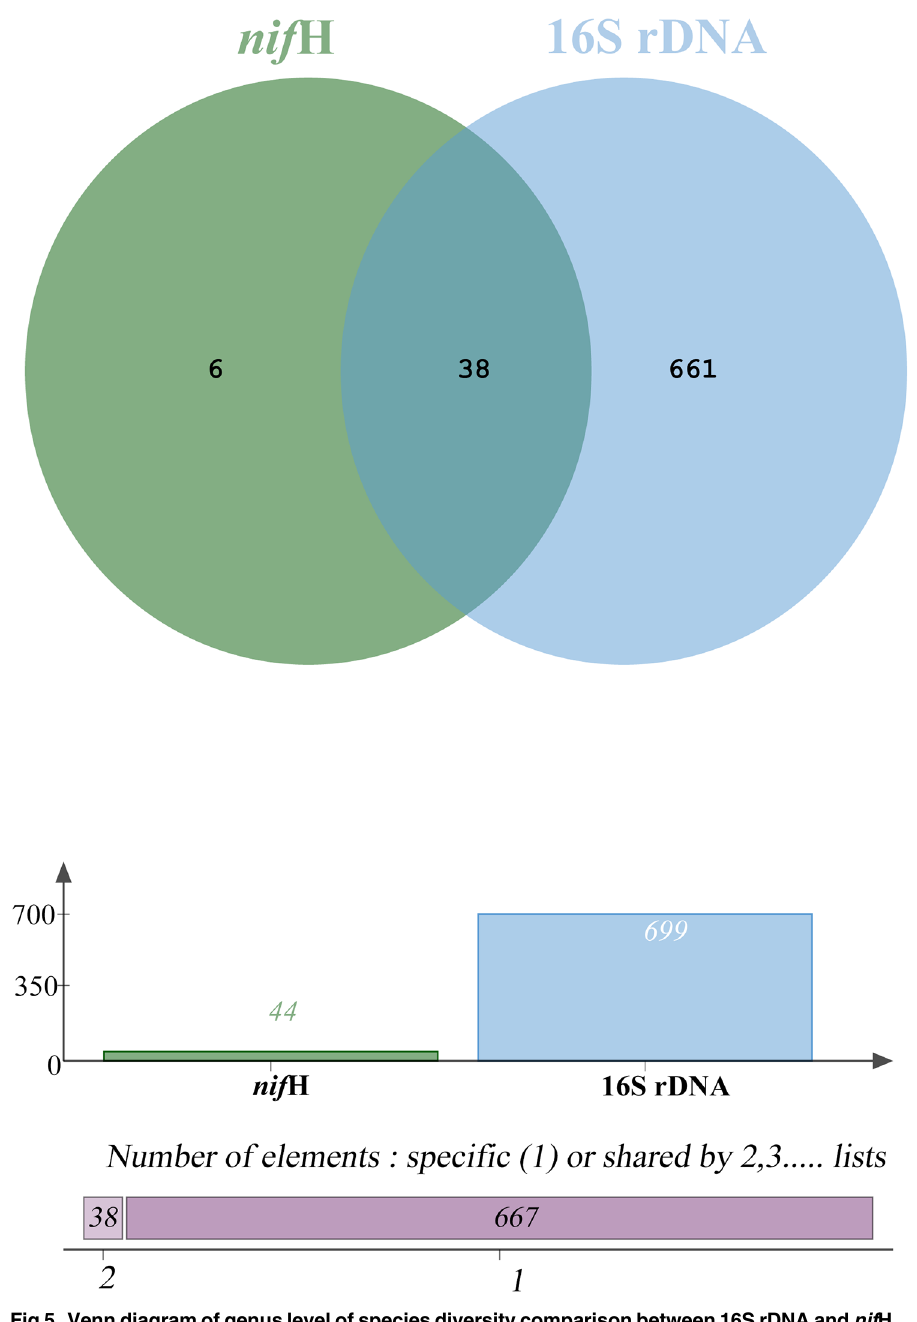
Fig 5. Venn diagram of genus level of species diversity comparison between 16S rDNA and nif H methods.